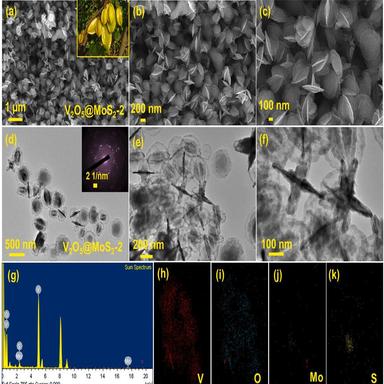
(a-c) FE-SEM images, (d-f) TEM images, (g) EDS spectrum, and (h-k) elemental mapping images of V, O, Mo, and S elements, respectively of the V2O5@MoS2–2 NCs material. The inset of (a) shows the photographic image of starfruit. The inset of (d) shows the SAED pattern of V2O5@MoS2–2 NCs material.